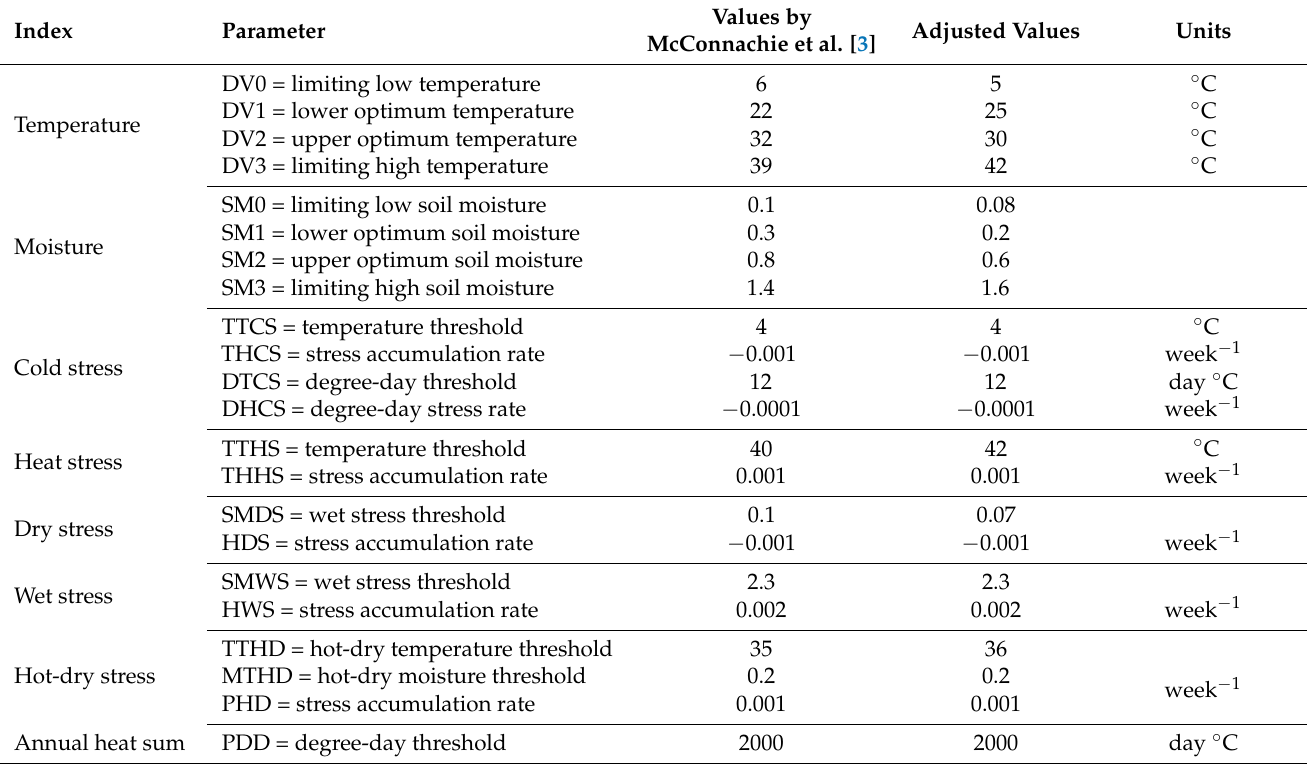
Table 1. CLIMEX parameter values used in this present study and those of McConnachie et al. [3] for modeling the potential distribution of parthenium